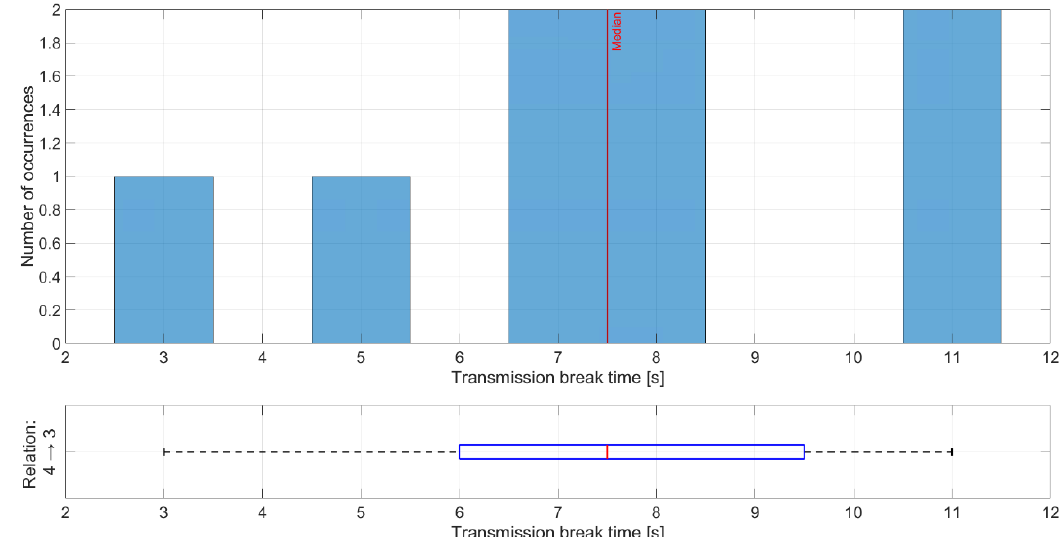
Figure 17. Distribution of transmission time breaks for relationship 1 and 2.